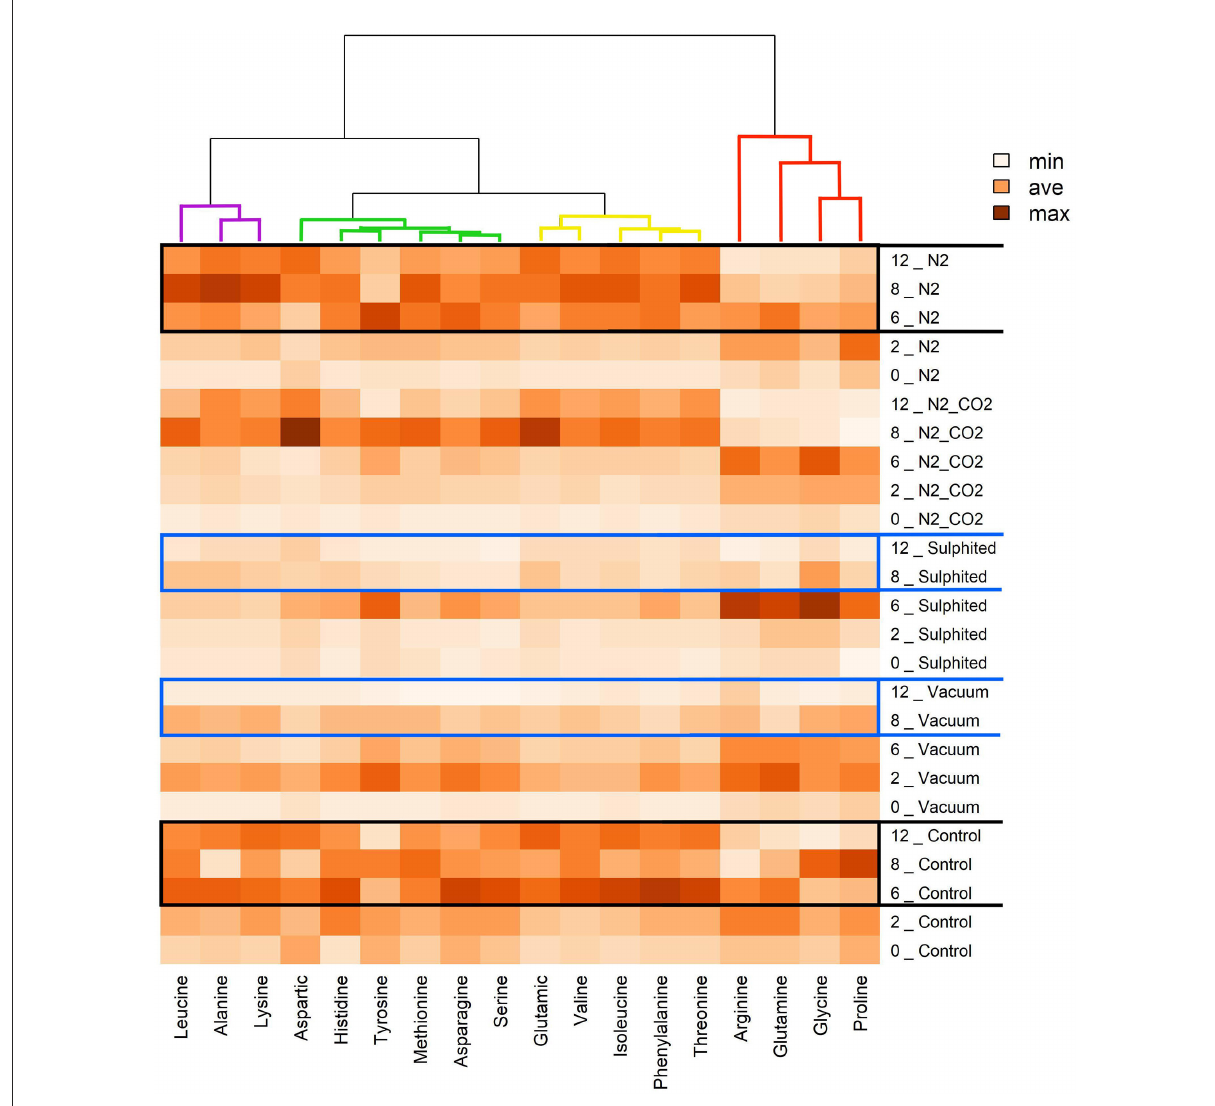
FIGURE6 Heat map visualization and clustering results of FAAs of deep water rose shrimps during frozen storage. The heat map was generated using hierarchical clustering analysis to identify the color intensity for each FAA (minimum intensity, no color; average intensity, yellow; maximum intensity, brown). Values adjacent to packaging methods represent frozen storage time in